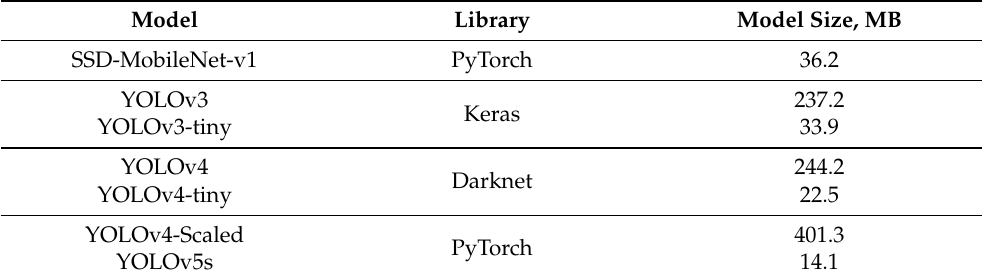
Table 1. Size and libraries used for the trained algorithms. Model Library Model Size,